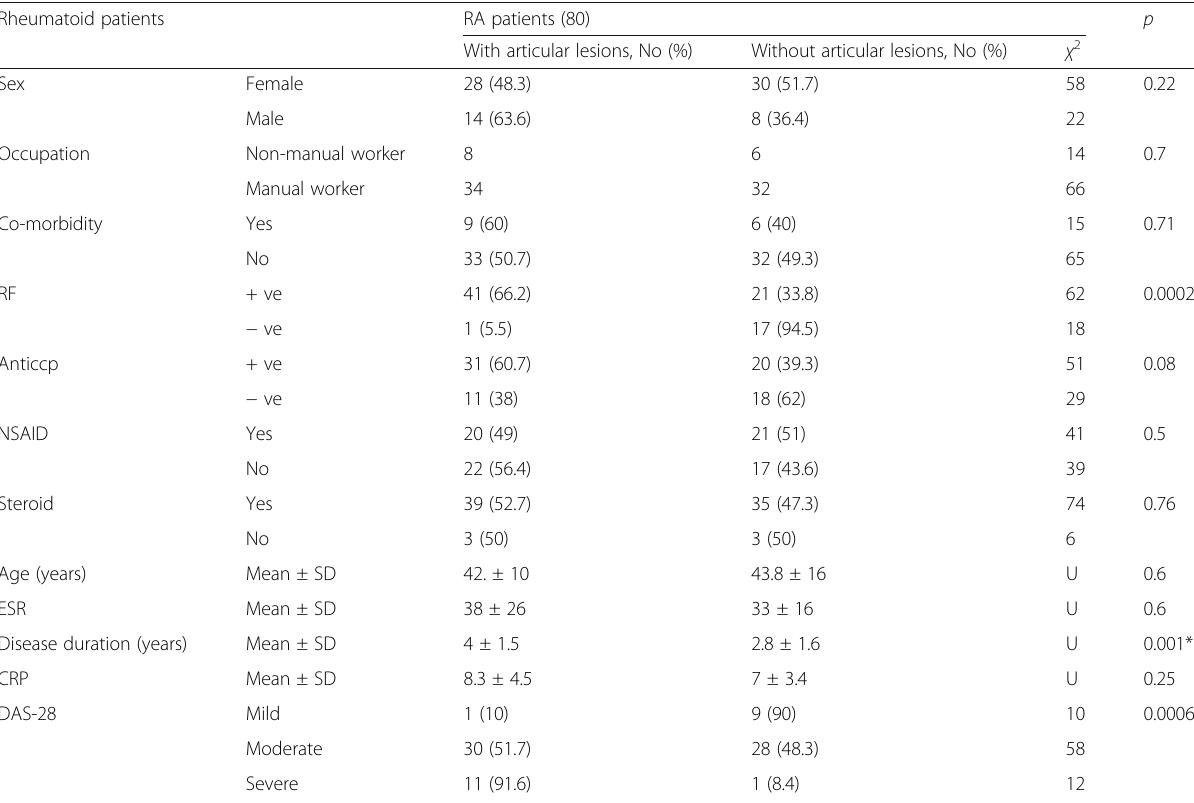
ESR erythrocyte sedimentation rate, CRP C-reactive protein, RF rheumatoid factor, anti-CCP anti-cyclic citrullinated peptide antibodies, DAS-28 score 28-joint count disease activity score, NSAID non-steroidal anti-inflammatory drugs, U Mann-Whitney test; χ 2 chi-square test *Added values are significant at p < 0.05